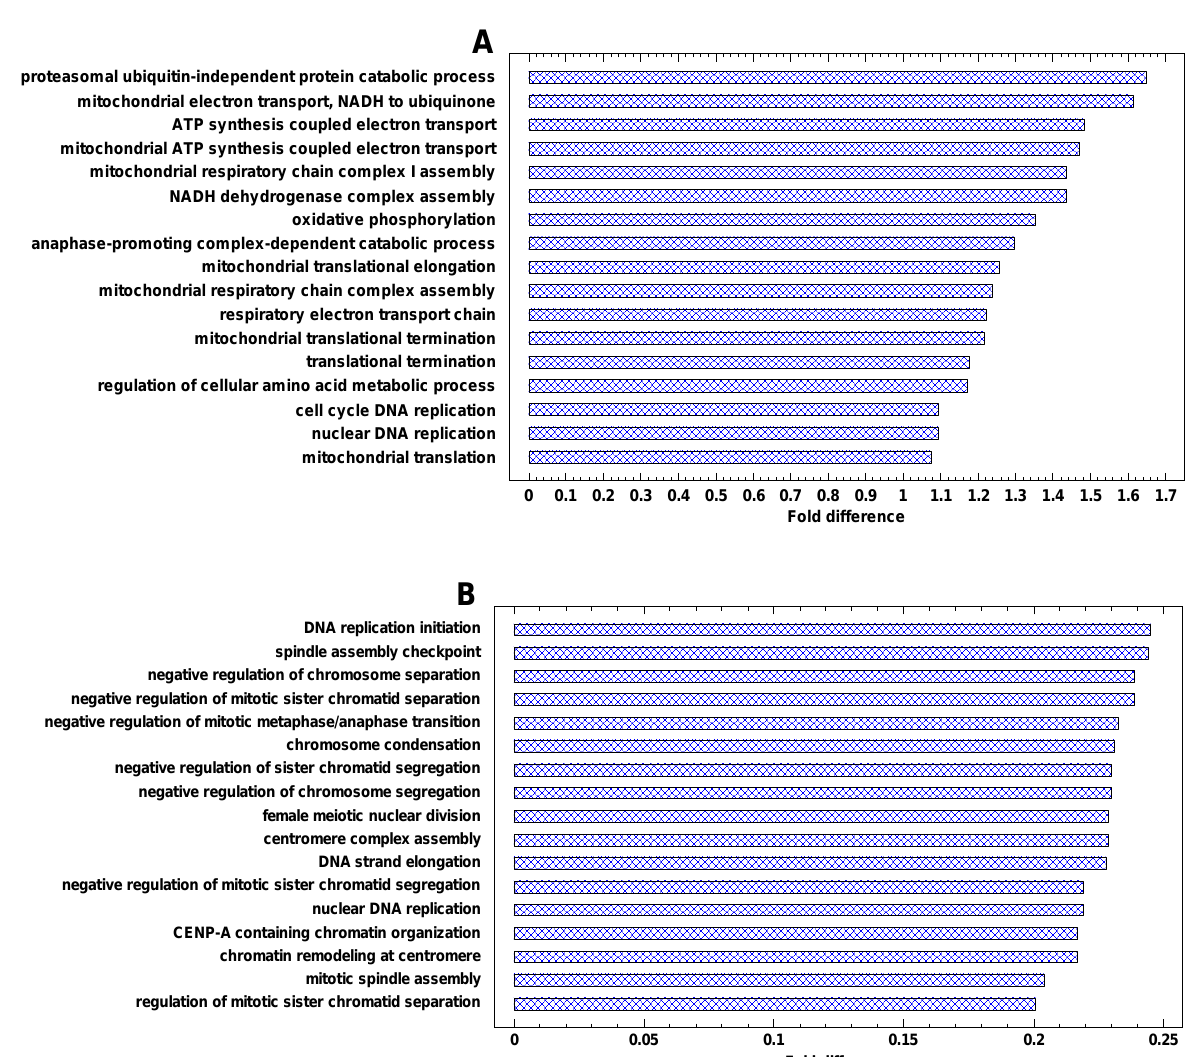
Figure 7. The most strongly enriched GO Biological Processes in the genes that are upregulated in the invasive and polyploid cancers. Fold difference: the difference between the mean cancer/normal expression fold for a given process and the mean fold for all processes (log2). The processes with the highest folds (and having >20 genes) are shown: ( A ) invasive/non-invasive fold (myeloma) ( p < 0.0001 at least); ( B ) polyploid/diploid fold (‘pancancer’, the data integrated over about 10,000 cancer samples) ( p < 0.0001 at least).